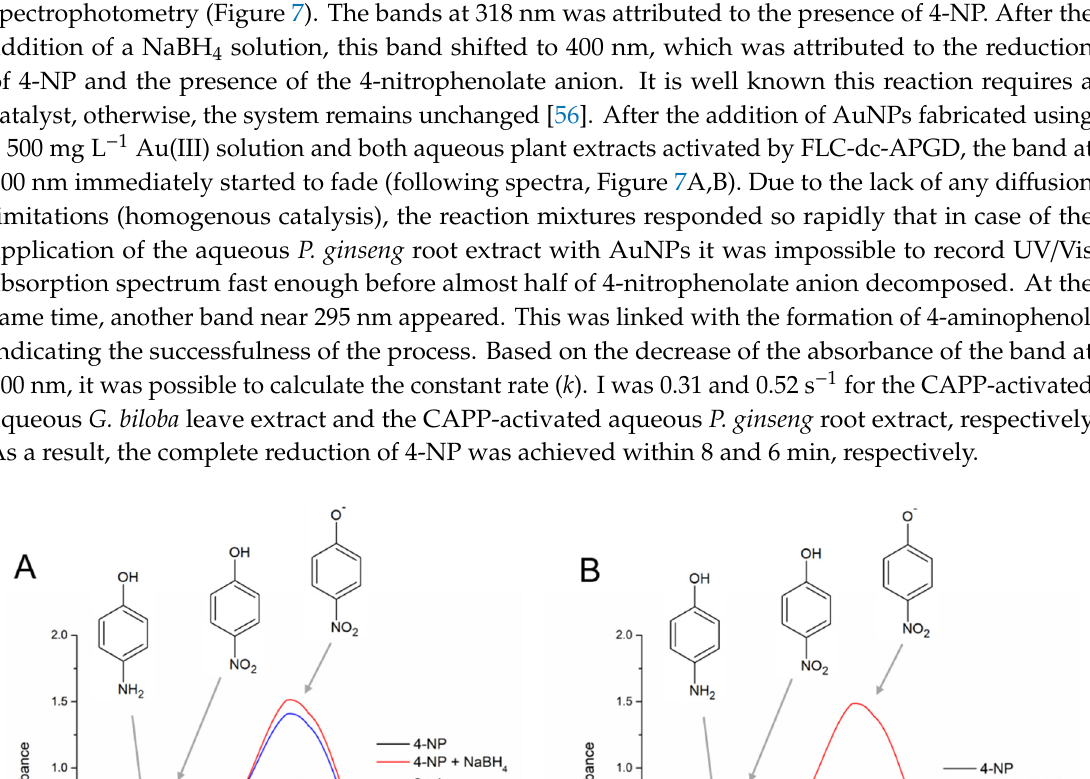
Table 4. Homogenous nanocatalysts for the catalytic decomposition of 4-nitrophenol.